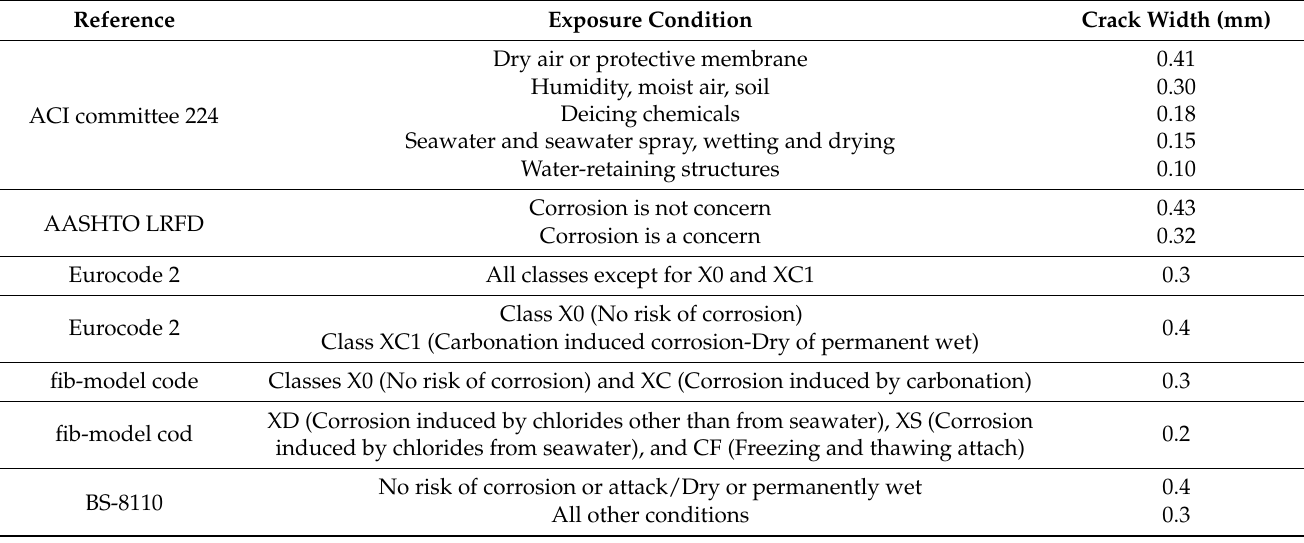
Table 1. Allowable crack widths from different codes. Note ACI and AASHTO values are converted from inches to